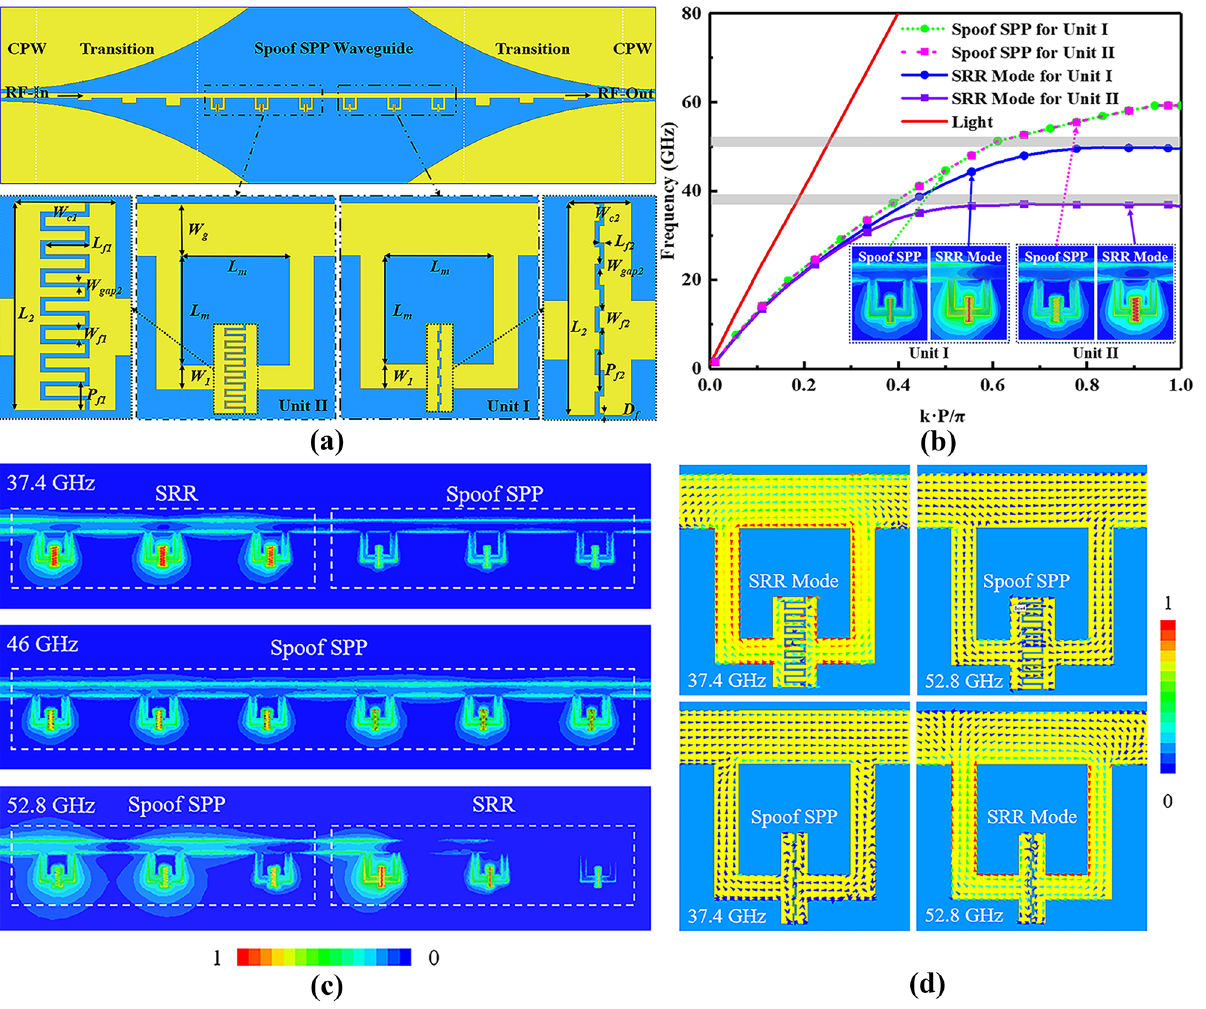
Figure 2. ( a ) Schematics of the two-frequency spoof SPP device with interdigital SRRs (The yellow part is gold, and the blue part is Si), whose dimensions are W g = 80 μm, L m = 166 μm, W 1 = 37 μm, L 2 = 135 μm, W c1 = 66 μm, L f1 = 29 μm, W gap2 = 3 μm, W f1 = 6.2 μm, P f1 = 29 μm, W c2 = 40 μm, L f2 = 3 μm, W gap2 = 3 μm, W f2 = 10.5 μm, P f2 = 27 μm, D f = 1.5 μm. ( b ) Dispersion diagram of the spoof SPP units. The grey rectangles are rejection bands. The inset shows the spoof SPP and SRR modes of the two spoof SPP units. ( c ) E-field distributions of the spoof SPP device with in-series interdigital SRRs. ( d ) Surface current density distributions the two spoof SPP